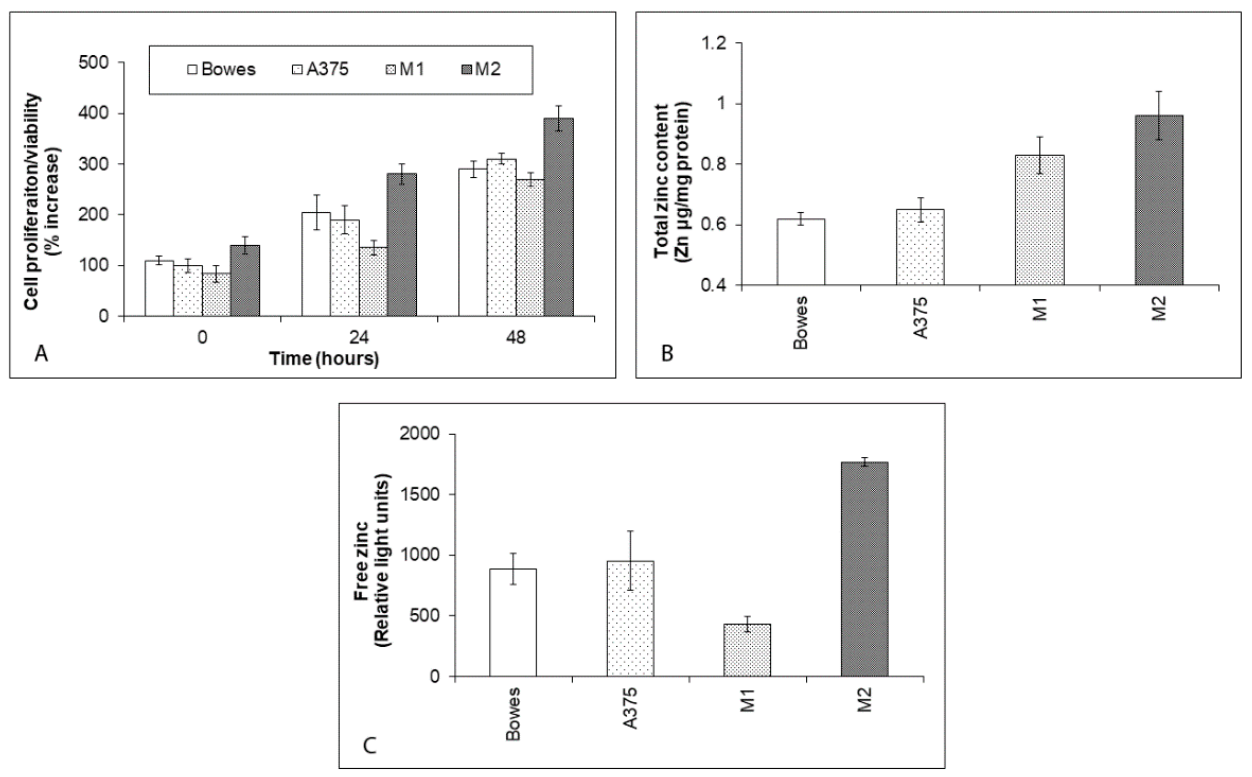
Figure 1. The proliferation and zinc content in human melanoma Bowes and A375 cell lines and explant melanoma cultures. Human melanoma cell lines Bowes and A375 and established explant human melanoma cultures (M1 and M2) were maintained upon standard laboratory conditions and their proliferation was determined by ( A ) colorimetric WST-1 assay. Values represent means ± SD of at least three experiments. ( B ) Total zinc content in human melanoma cell lines Bowes and A375 and established explant human melanoma cultures (M1 and M2) as determined by absorption spectrometry. ( C ) Free (labile) zinc in human melanoma cell lines Bowes and A375 and established explant human melanoma cultures (labeled M1 and M2) as measured by microfluorimetry. Values represent means ± SD of at least three experiments.